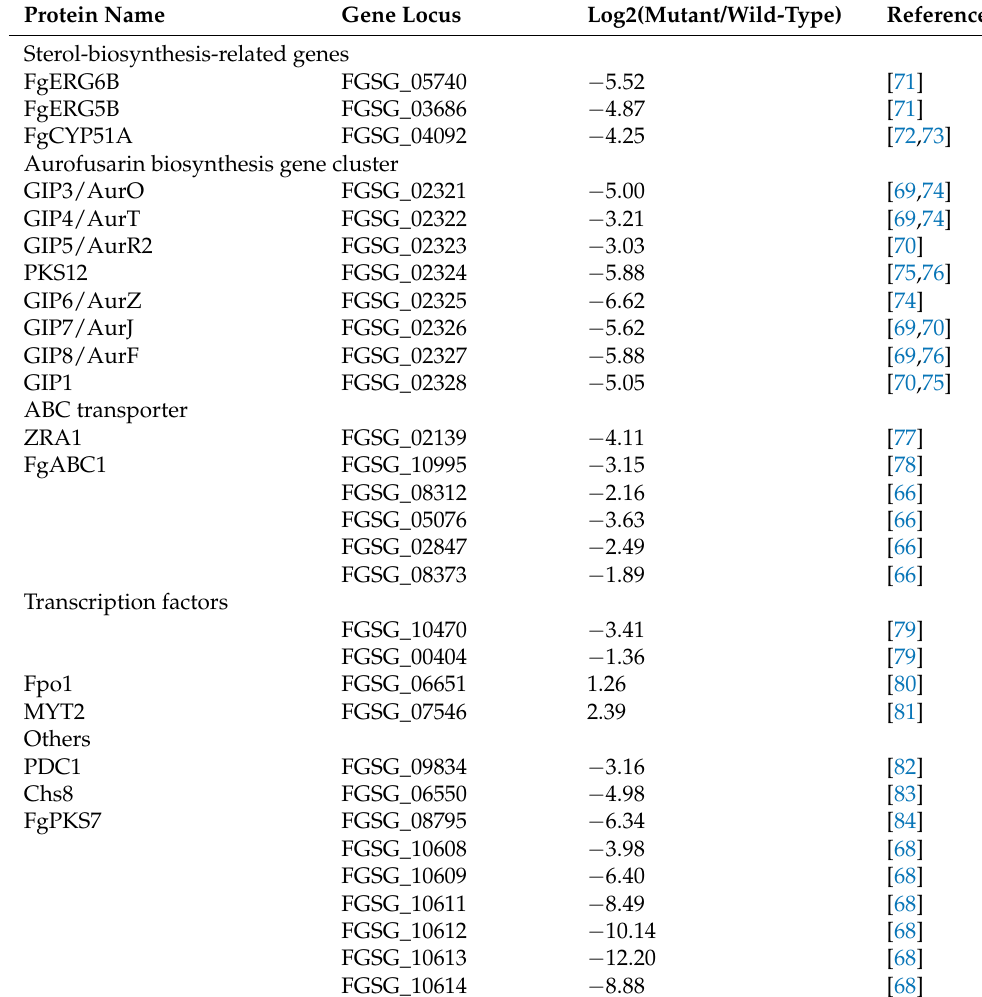
Table 1. List of several DEGs that may be involved in the phenotype mentioned